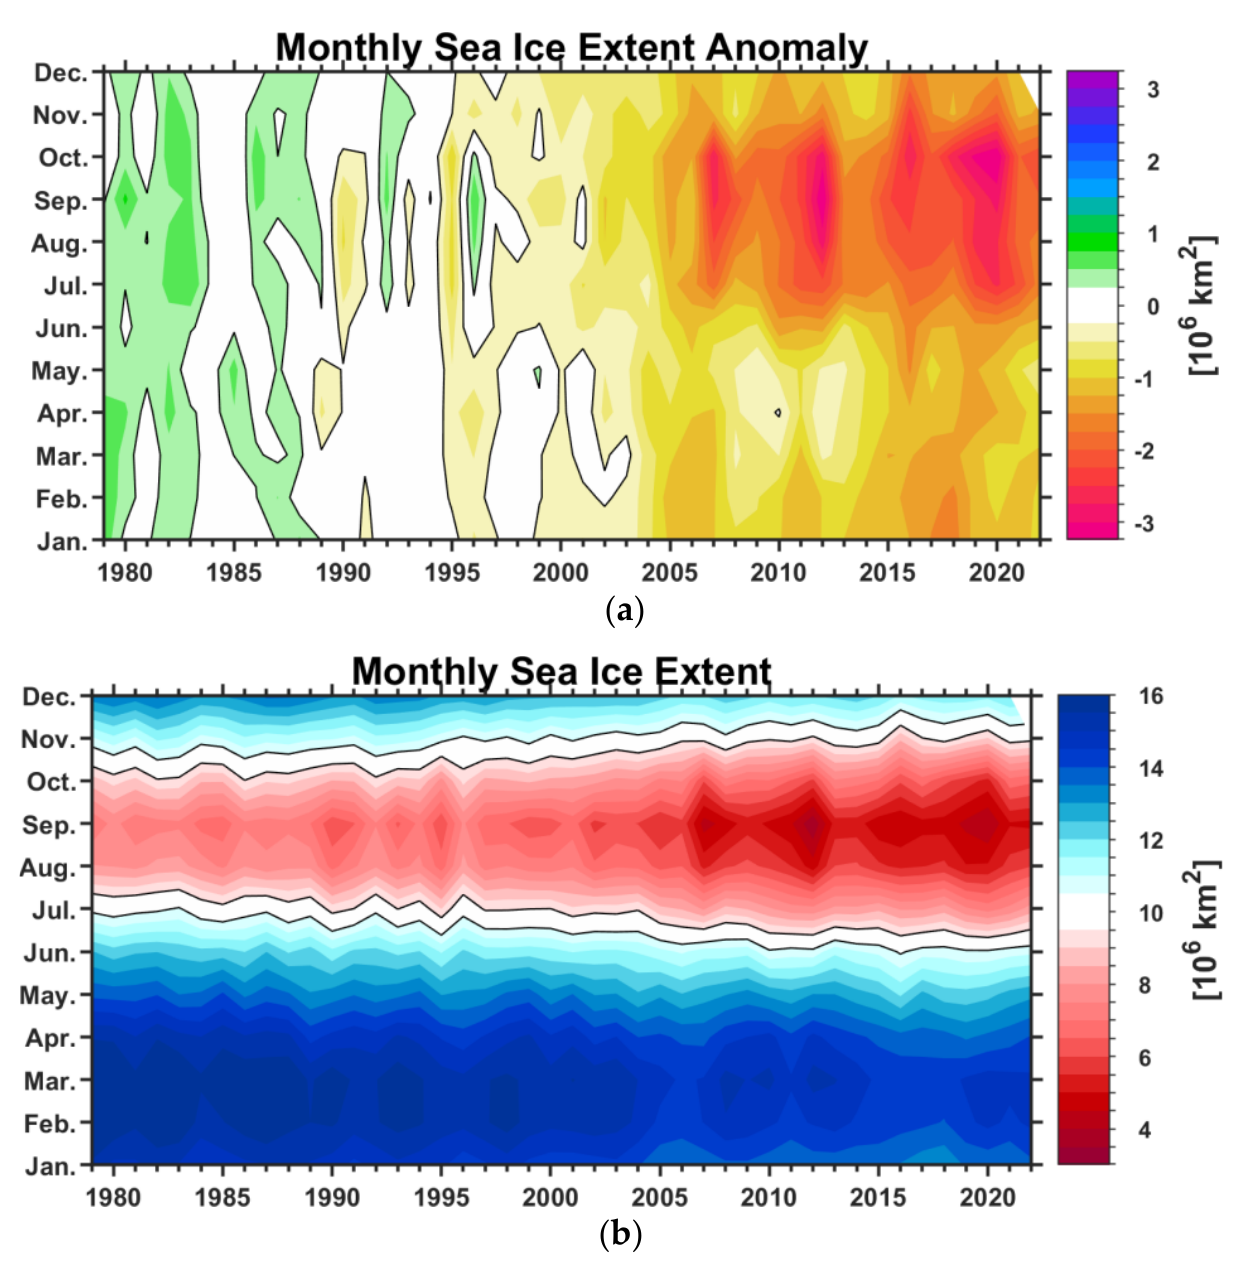
Figure 2. ( a ) Monthly sea ice extent time series anomalies from 1979 to 2022 and ( b ) monthly sea ice extent time series. Data source: ftp://sidads.colorado.edu/DATASETS/NOAA/G02135/, accessed on 29 November 2017. Table 1. Monthly sea ice extent trends over the period 1979 – 2016 (units: 10 6 km 2 /decade).